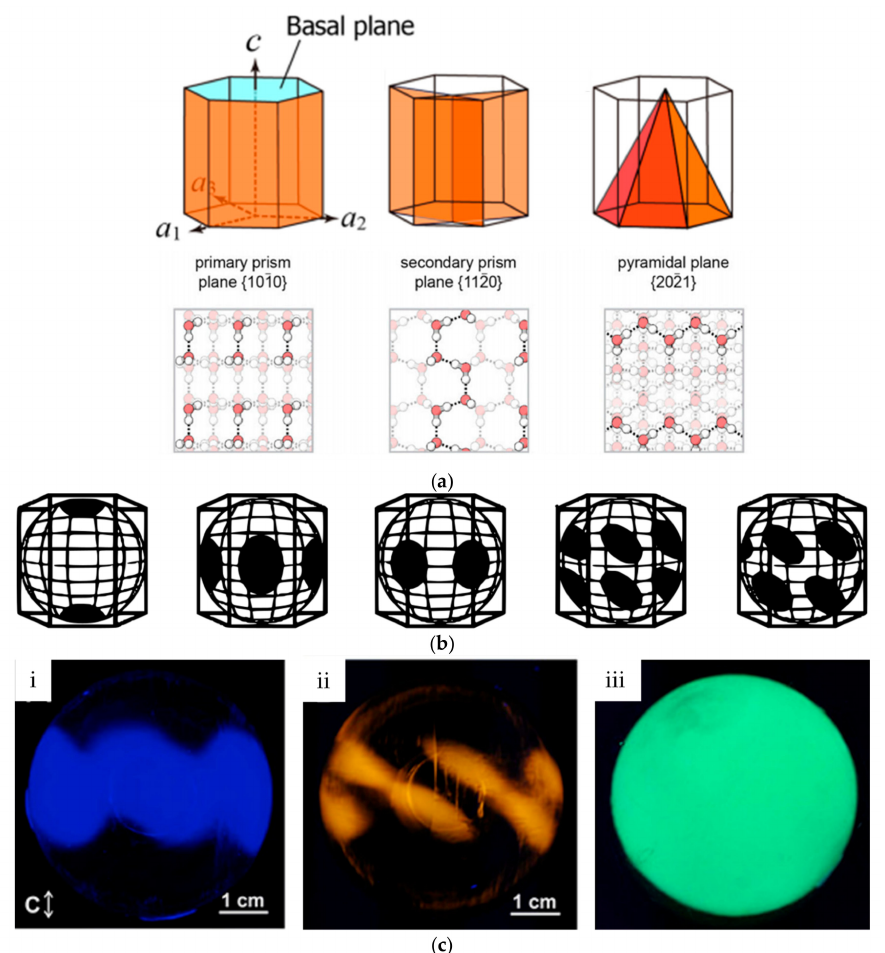
Figure 5. ( a ) Cartoon representation of specific ice crystal planes in the hexagonal ice lattice to which IBPs bind. The basal plane (normal to the c-axis) is shown in cyan. In orange are depicted the primary prism planes (left), the secondary prism planes (middle), and the pyramidal planes (right). Reprinted with permission from Sci. Rep. 2019 , 9 , 2212; ( b ) Fluorescence-based ice plane a ffi nity (FIPA) experiments on a single ice crystal using fluorescently tagged AFPs to identify the planes the proteins attach to. The planes identified using this technique are (from left to right): basal plane, primary prism plane, secondary prism plane, pyramidal plane aligned with a-axes, pyramidal plane o ff set of a-axes. ( c ) FIPA experiments on (i) pacific-blue-labeled type III AFP, (ii) TRITC-labeled type I AFP, (iii) and GFP-tagged Mp AFP. Adapted from Basu, K., Garnham, C. P., Nishimiya, Y., Tsuda, S., Braslavsky, I., Davies, P. Determining the Ice-binding Planes of Antifreeze Proteins by Fluorescence-based Ice Plane A ffi nity. J. Vis. Exp. 2014 , 83 , e51185, doi:10.3791 / 51185